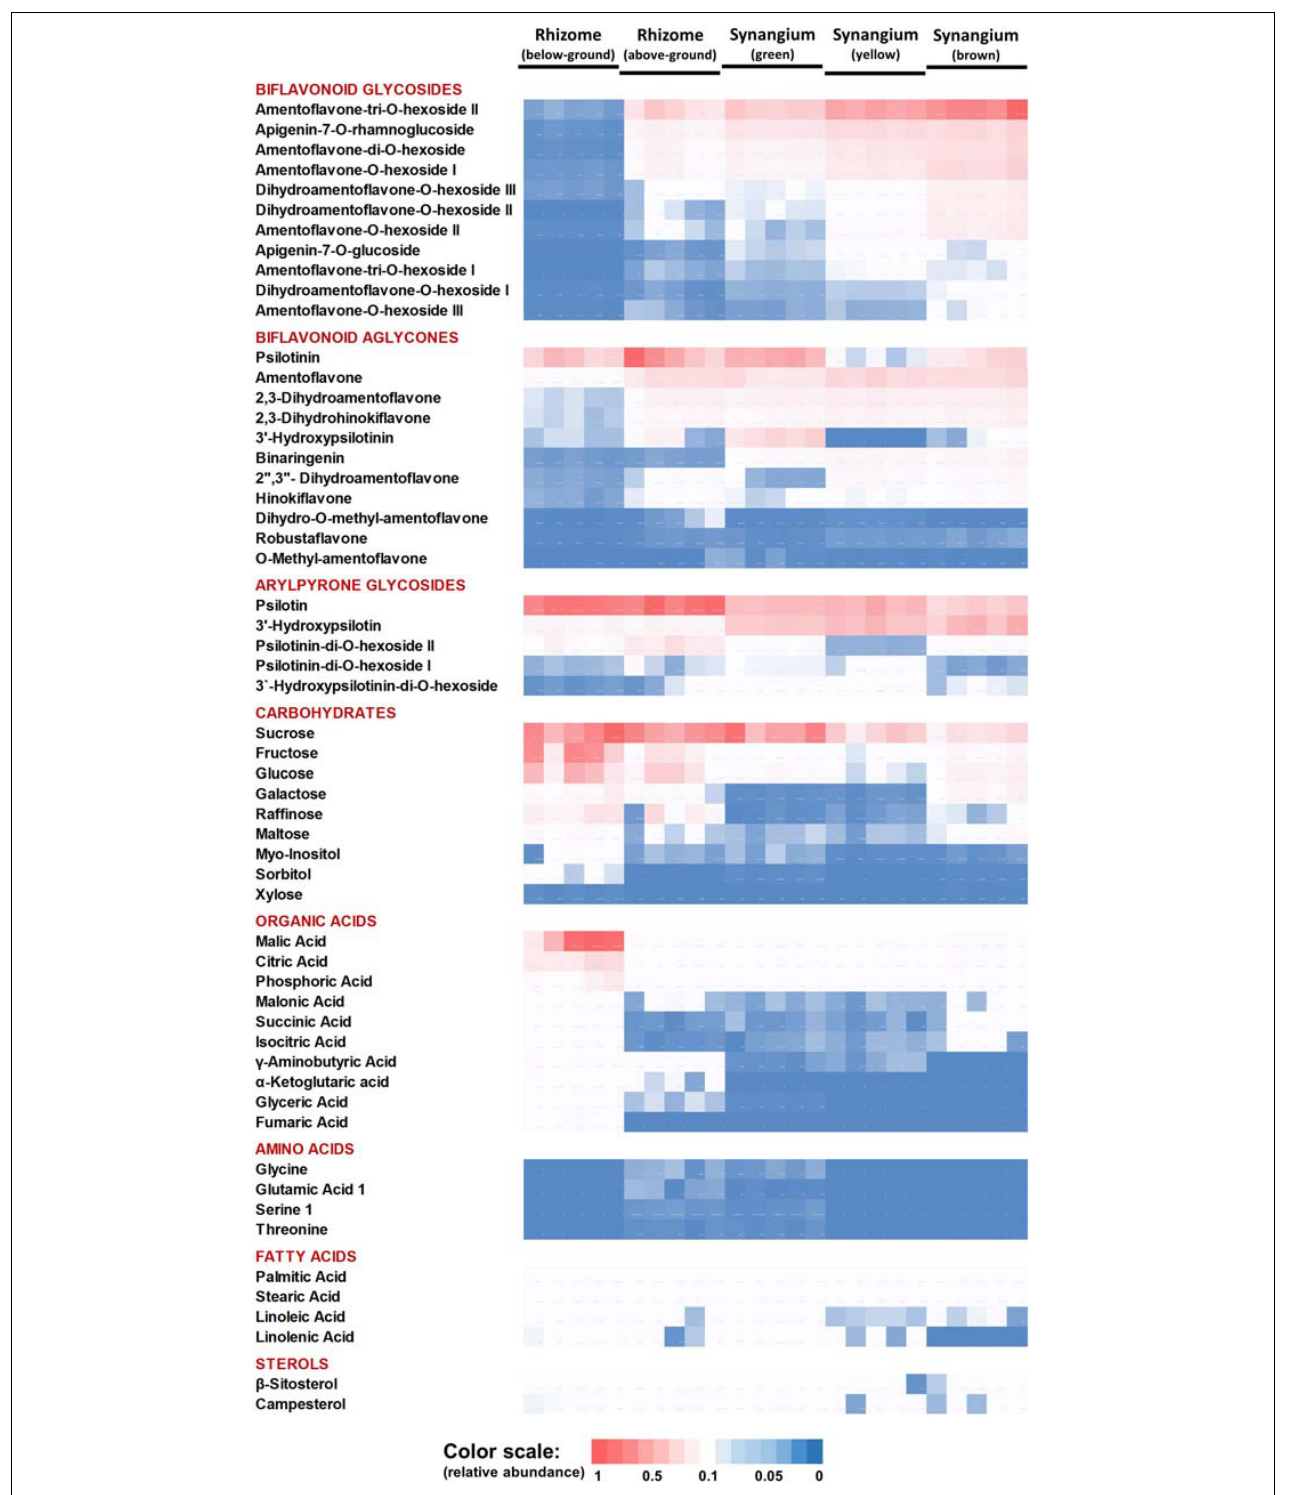
FIGURE 4 | Heat map visualizing the organ-specificity of metabolite accumulation in P. nudum . A color code (red-white-blue) is used to indicate the relative abundance of metabolites based on normalized mass spectral intensities.